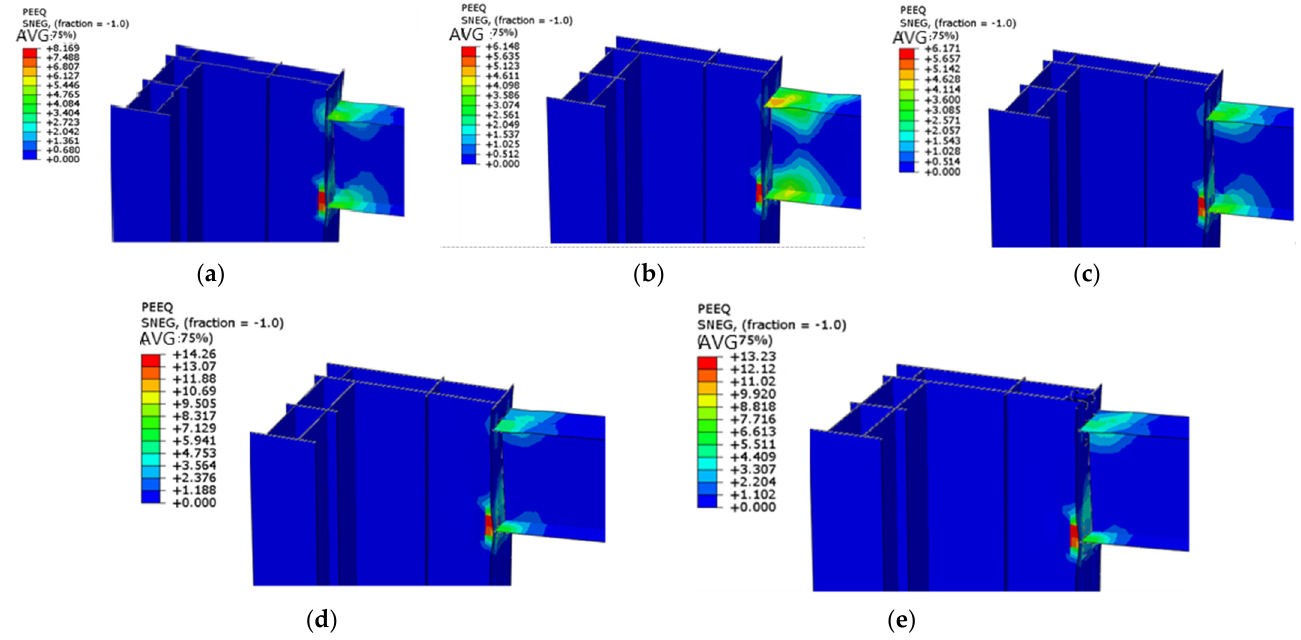
Figure 9. Equivalent plastic strain cloud diagram (unit: %). ( a ) S-1; ( b ) S-2; ( c ) S-3; ( d ) S-4; ( e ) S-5.